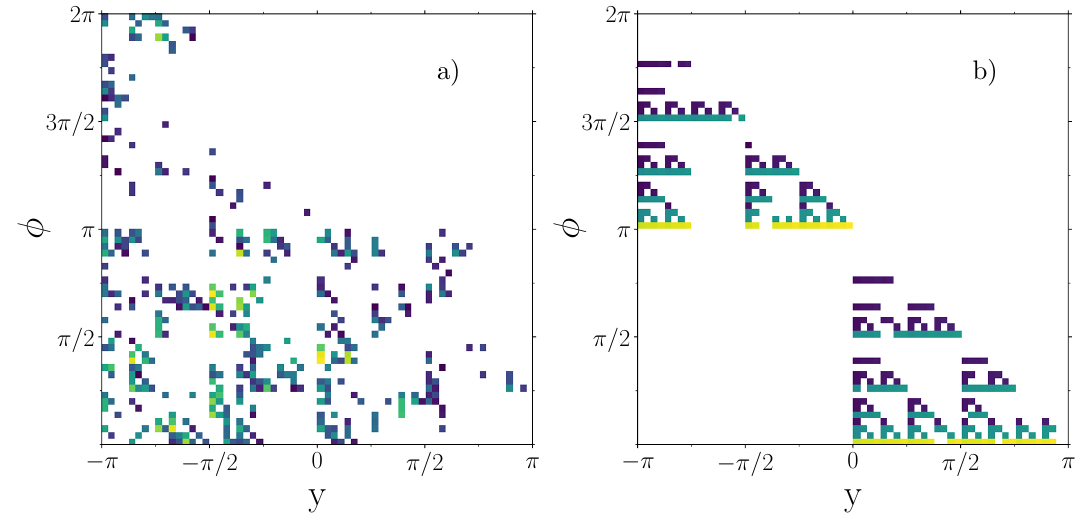
Figure 4 . Example emission patterns produced by an untrained (chaotic) CNN (a) and an over- trained (periodic) CNN (b). The input to the CNN was the same in both